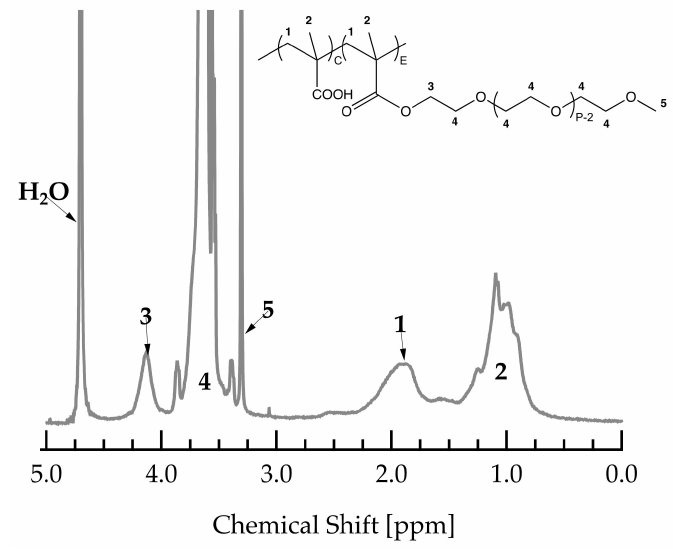
Figure A3. 1 H-NMR spectrum of a PCE with PMAA backbone and MPEG side